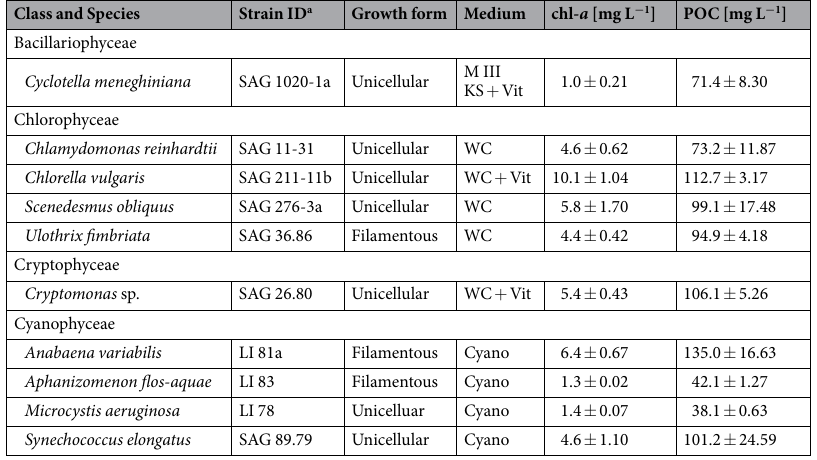
Table 1. Phytoplankton class, species and strain information, growth form, growth media, chlorophyll -a (chl- a ) and particulate organic carbon (POC) concentrations in cultures used for trace gas production measurements. Algal cultures were grown in 4 L volumes at a temperature of 20 °C and a light intensity of ~100 µ mol m − 2 s − 1 from fluorescent tubes. Cyanobacteria were grown in Cyano medium 74 , Chlorophyceae and Cryptomonas sp. were cultivated in Woods Hole (WC) medium either with or without vitamins 75 , and diatoms were grown in a modified M III medium with vitamins (M III KS) 76 . Data show mean ± standard deviation (n = 3). a SAG = Culture collection of algae, University of Göttingen; LI = Culture collection of the Limnological Institute, University of Konstanz.